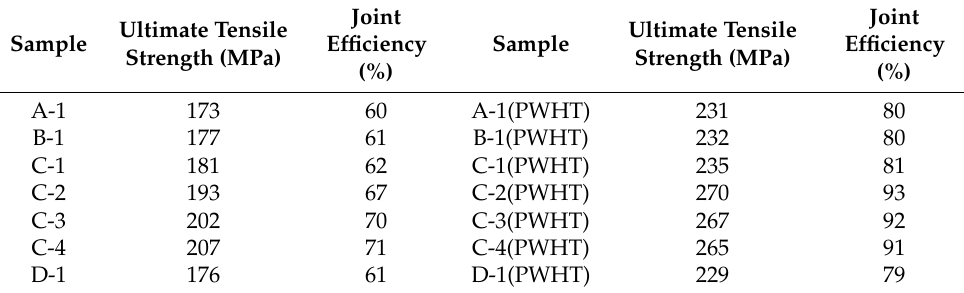
Table 4. Tensile properties of dissimilar FSWed Al5083-Al6061(T6).